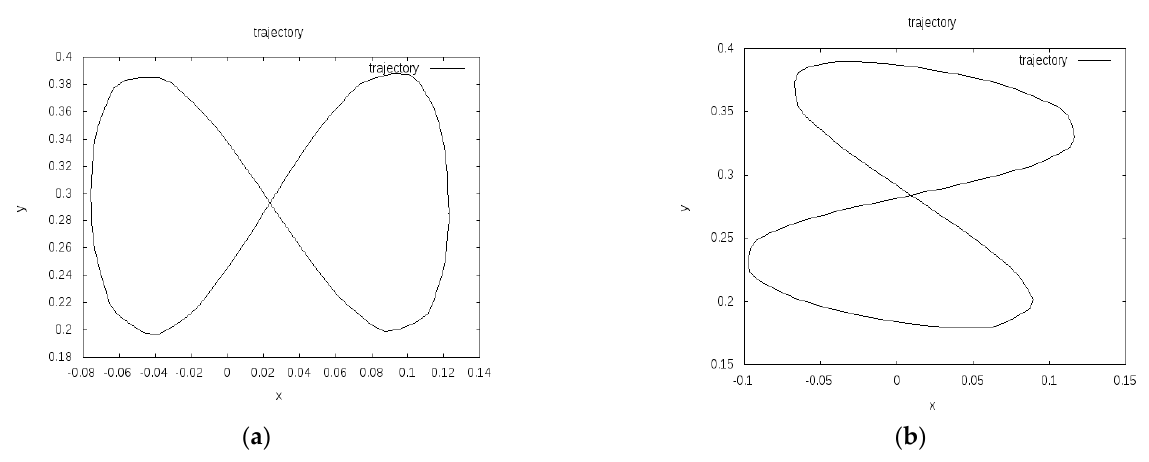
Figure 4. Best ( a ) and bad ( b ) placement of the path ‐ following task, as determined by the GA.